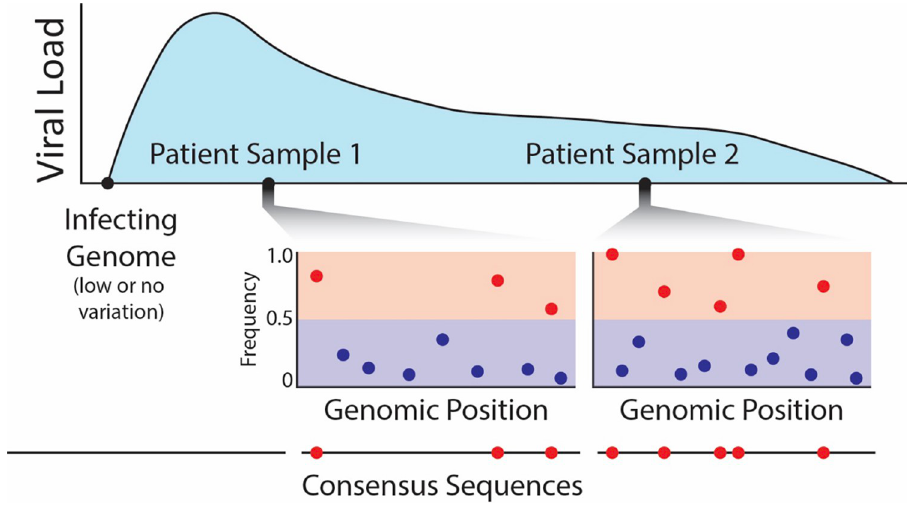
Fig 4. An example of clinical sampling of a patient over the course of an infection, demonstrating how a consensus sequence-based summary neglects the great majority of intra-host variants (which are expected to primarily segregate at low frequencies [shown as blue circles]). This ascertainment of high-frequency intra-host variants (shown as red circles) for subsequent inter-host comparison thus represents an unfortunate and unnecessary loss of